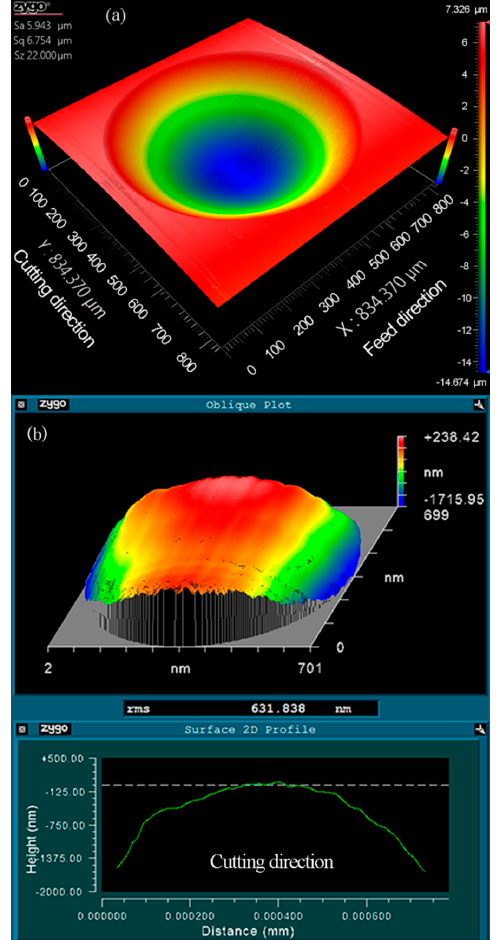
Figure 14. Zygo photographs of micro lens. ( a ) 3-D topography of machined micro lens; ( b ) The form error of machined micro lens surface from a designed sphere ( n = 400, t = 1.5 ms).